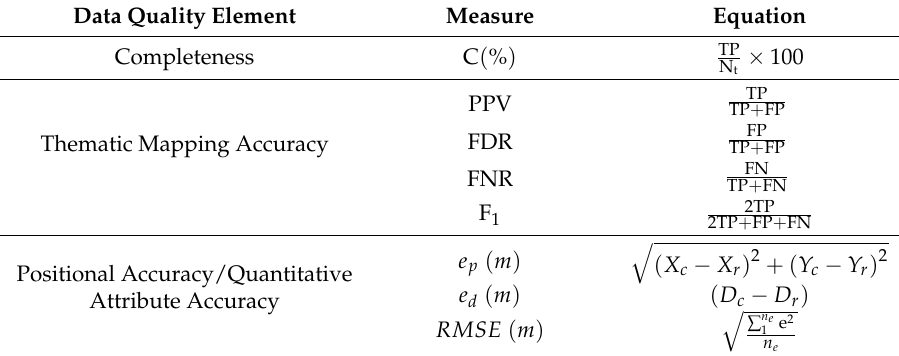
Table 4. The adopted spatial data quality measures in this study (where TP : true positive; FP: false positive; FN: false negative; N t : total number of counted tree crowns in the reference data for the study unit (parcel or test plot); ( X c , Y c ): coordinates of a tree crown centroid for the crowdsourced observations; ( X r , Y r ): coordinates of a tree crown centroid for the reference observations; e: error ( e p or e d ); and n e : total number of